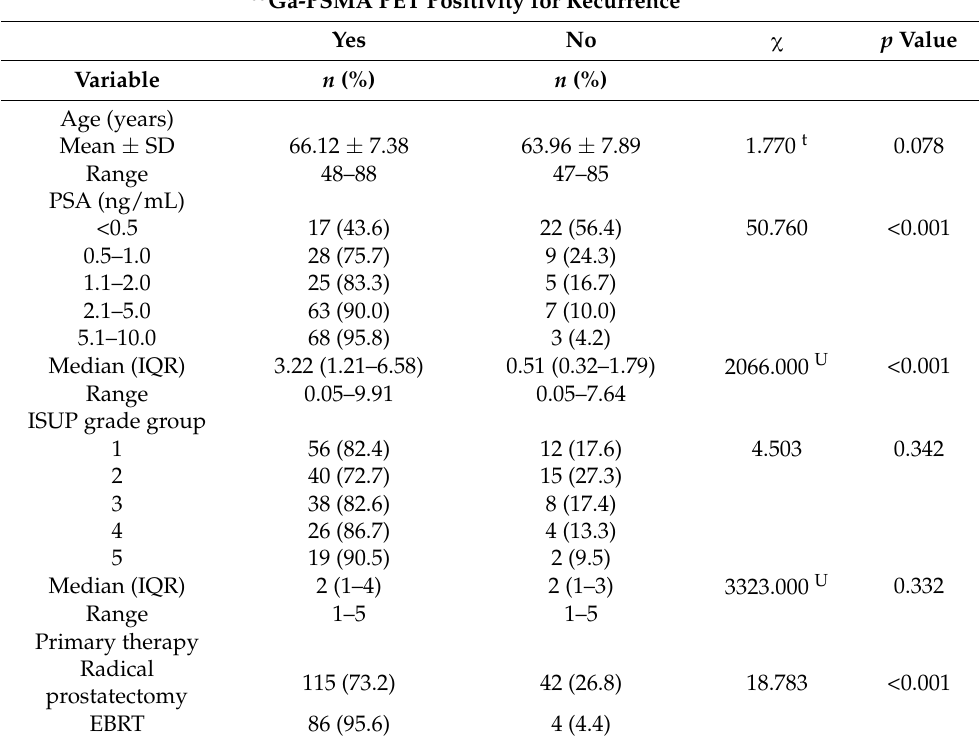
Table 5. Comparison of patients with positive 68 Ga-PSMA-11 PET/CT finding versus patients with negative finding for prostate cancer recurrence. 68 Ga-PSMA PET Positivity for